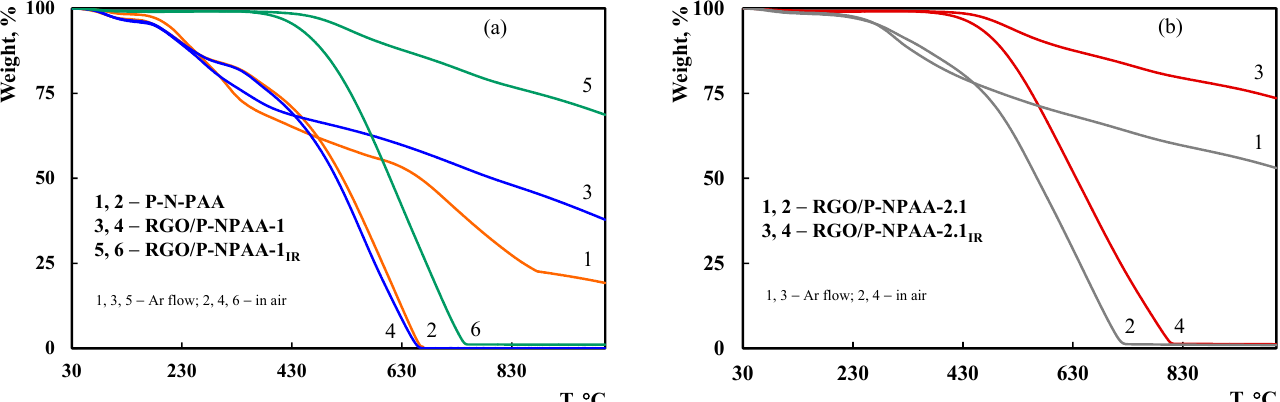
Figure 2. TGA thermograms of RGO/P-N-PAA, prepared via oxidative polymerization ( a ) and from a solution ( b ), at heating up to 1000 ◦ C in air (2, 4, 6) and in the argon flow (1, 3, 5).